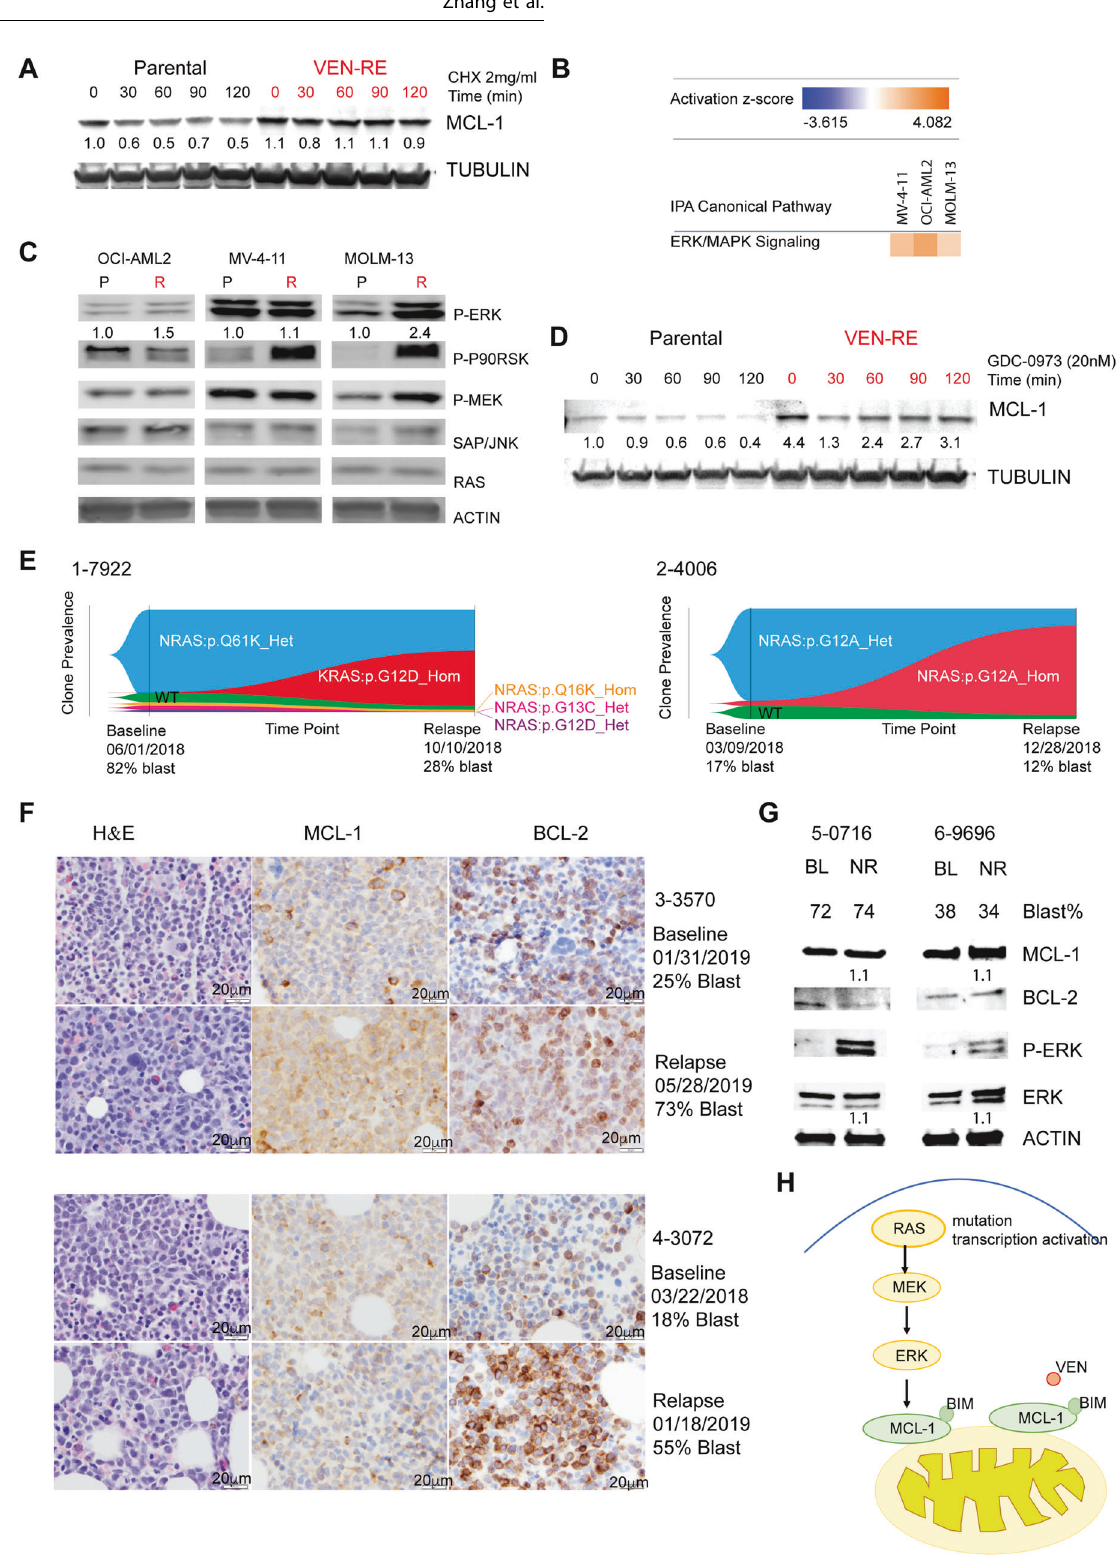
Fig. 4 MAPK pathway activation in VEN-RE cells upregulated MCL-1. a Western blots showing MCL-1 protein levels in parental and VEN-RE MOLM-13 cells treated with 2 mg/mL cycloheximide (CHX) for 0 – 120 min. b Heatmap showing activation scores for ERK/MAPK signaling in VEN-RE cells based on pathway analysis of the RNA sequencing data. c Western blots showing protein levels of MAPK pathway components in parental (P) and VEN-RE (R) cells. d Western blots showing protein levels of MCL-1 in parental and VEN-RE MOLM-13 cells treated with 20 nM of the MEK inhibitor GDC-0973 (GDC) and 2 mg/mL CHX for 0 – 120 min. e Fishplots showing clone prevalence at two time points (baseline and relapse) in patient samples 1-7922 and 2-4006. f MCL-1 and BCL-2 expression by immunohistochemistry (IHC) in two paired samples from patients at the time of relapse on VEN clinical trial. Scale bar on the bottom right indicates 20 μ m. g Protein expression in two AML patients primary refractory to VEN-based therapy pre- (BL) or post-treatment (no response, NR). h Mechanism of VEN resistance: RAS/MAPK/MCL-1 axis Signal Transduction and Targeted Therapy (2022)